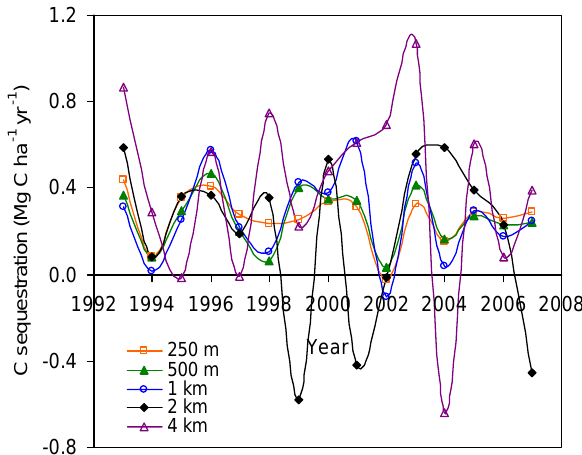
Fig. 4. Temporal changes of carbon sequestration between 1992 and 2007 for five spatial resolutions.